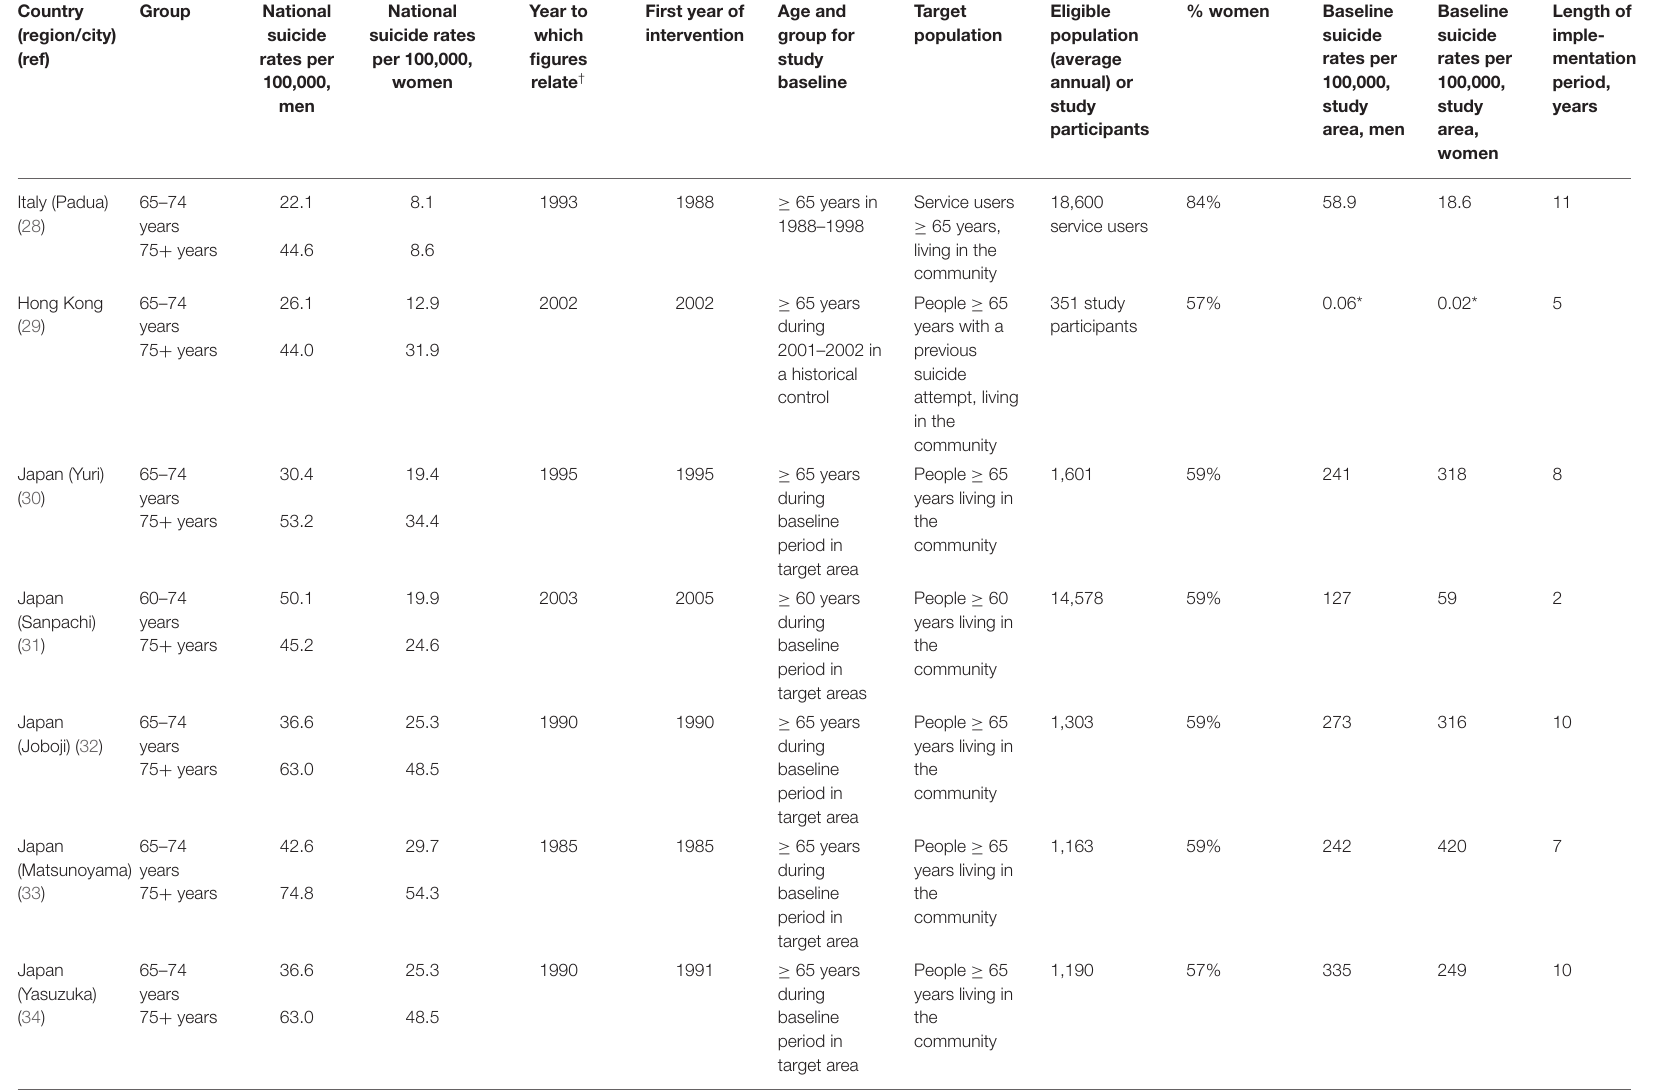
TABLE 2 | Demographic and suicide data for the studies, including nationally and for the study areas. Country (region/city)